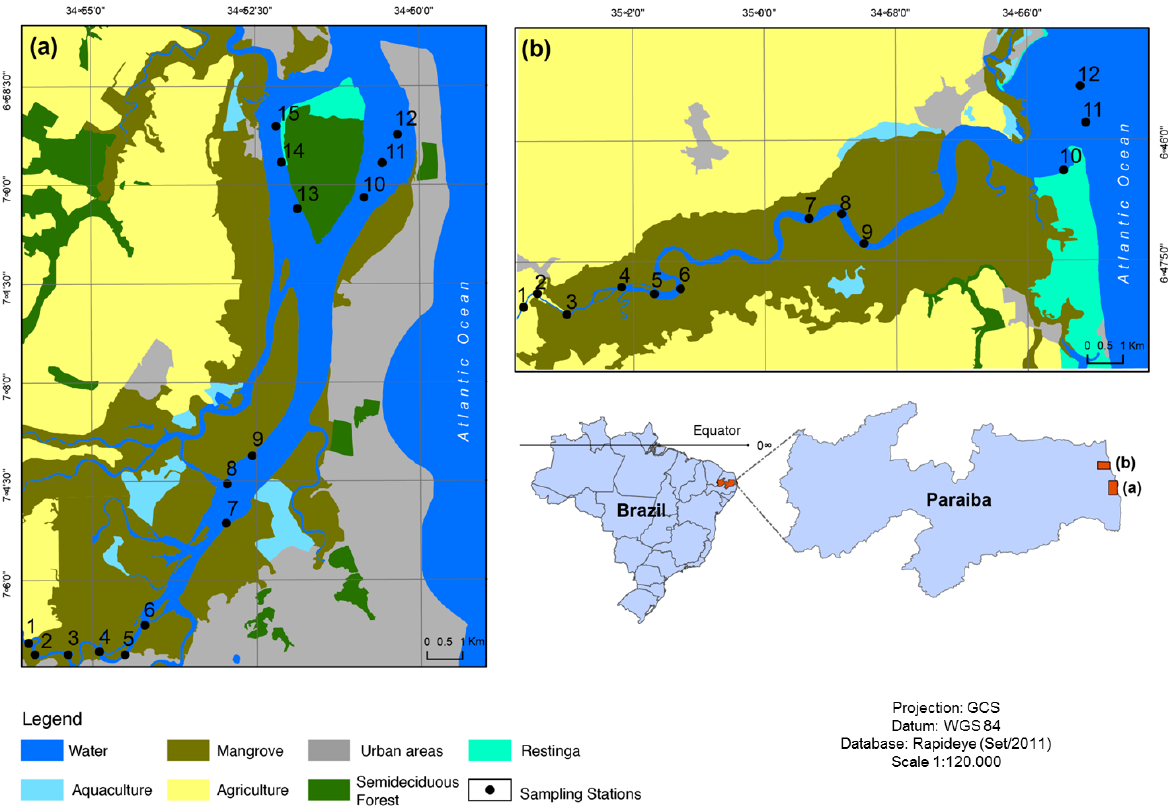
Figure 1 - Estuaries of the river Paraíba do Norte (PN) ( a ) and Mamanguape (MM) ( b ), State of Paraíba, Brazil. Collection points and land use